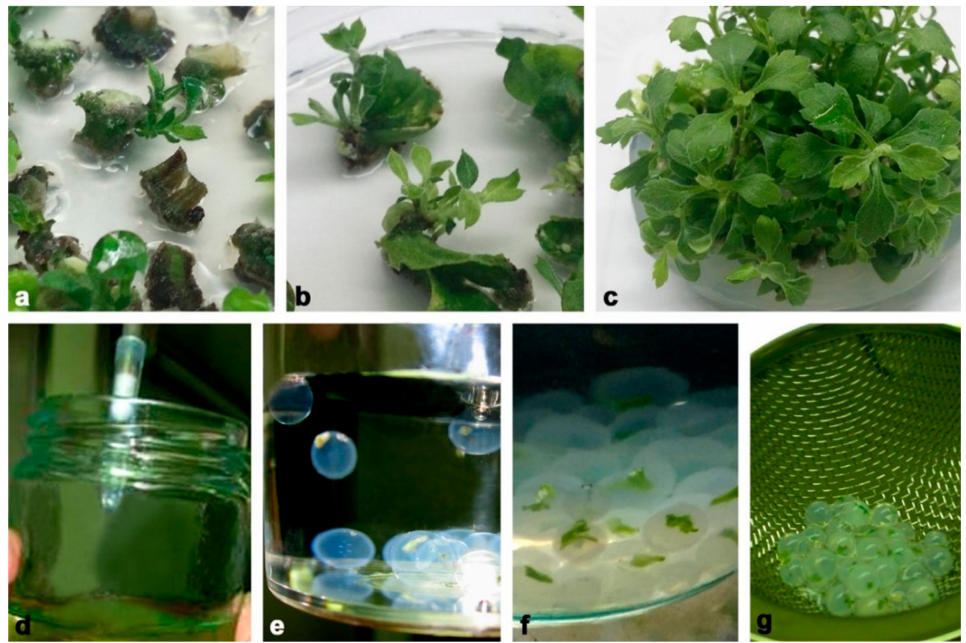
Figure 12. Chrysanthemum synthetic seed production. ( a , b ) Initiation of shoot regeneration in steam segment of cv. PC ( a ) and leaf culture of cv. BL ( b ); ( c ) stock shoot cultures used as primary explants for synthetic seed production; ( d ) sucking of shoot tips with sodium alginate; ( e ) formation of alginate beads in complex solution consisting of 100 mM CaCl 2 × 2H 2 O; ( f ) well-formed alginate beads after 20 min in complex solution; ( g ) washed synseeds ready for